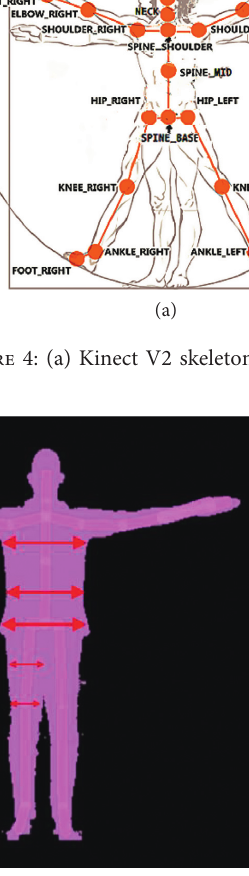
Figure 5: Background removed body index image with front horizontal curve in depth